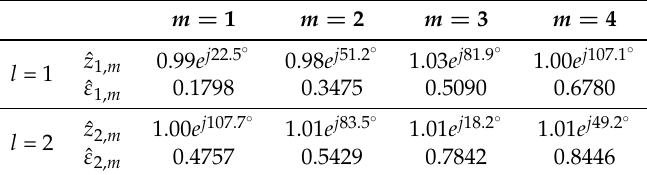
Table 2. The vector quantities and normalized frequencies of two undersampled sequences in Step 4.